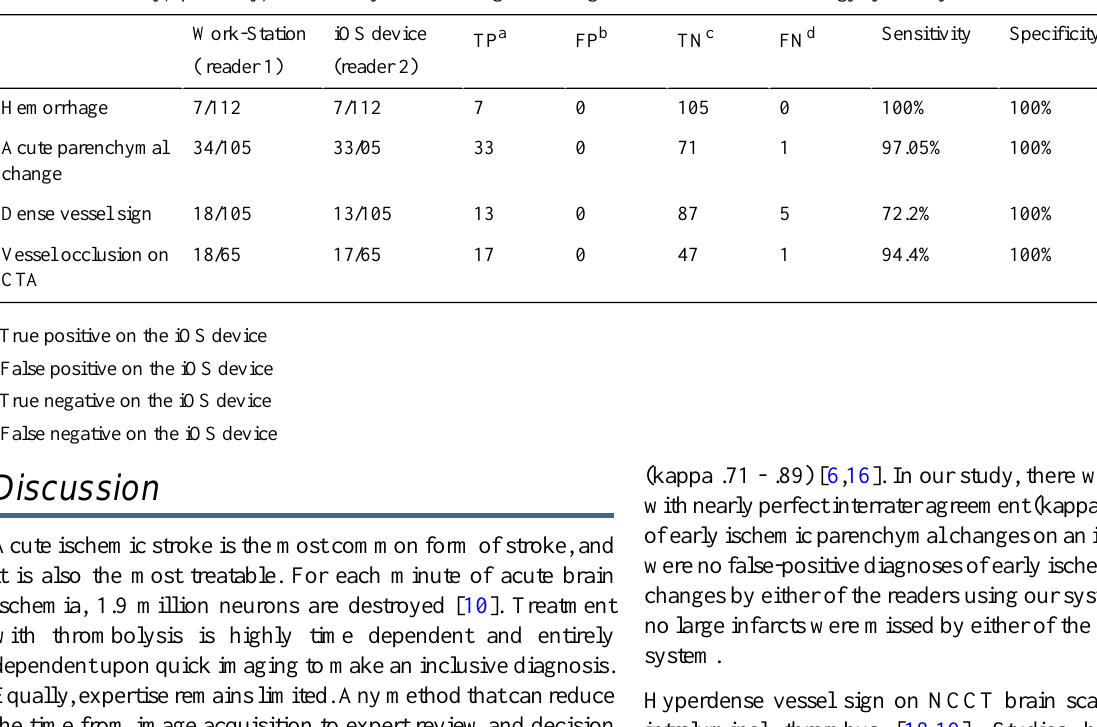
Table 2. Sensitivity, specificity, and accuracy of stroke diagnosis using the client-server teleradiology system by reader